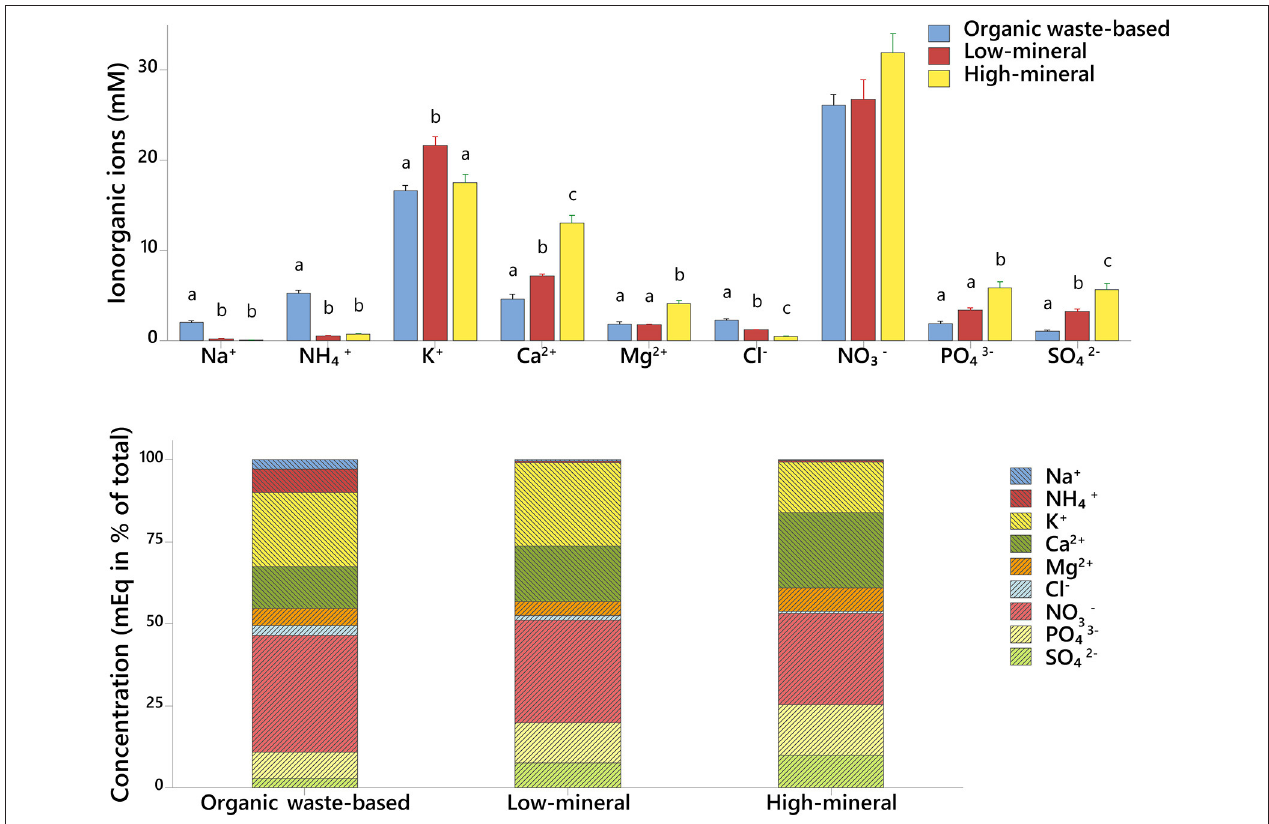
FIGURE 5 | Ionic composition of xylem sap of plants cultivated with different fertilizers. Upper graph, concentration of individual inorganic ions in mmol. Lower graph, ratios of individual inorganic ions in mEq. Mean values ± SD are shown. Different letters indicate statistically significant differences at p = 0.05, n =